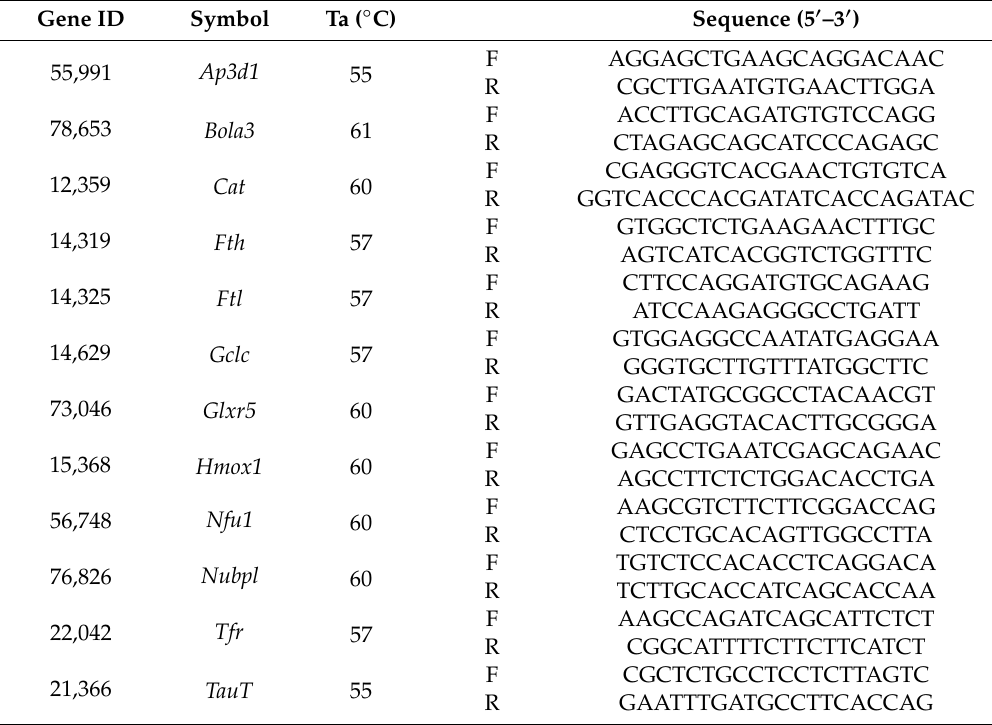
Table 2. Nucleotide sequences of primers used for quantitative real-time PCR. Primer pairs are listed as forward (F) and reverse (R) with the corresponding annealing temperature (Ta) that was determined individually for all